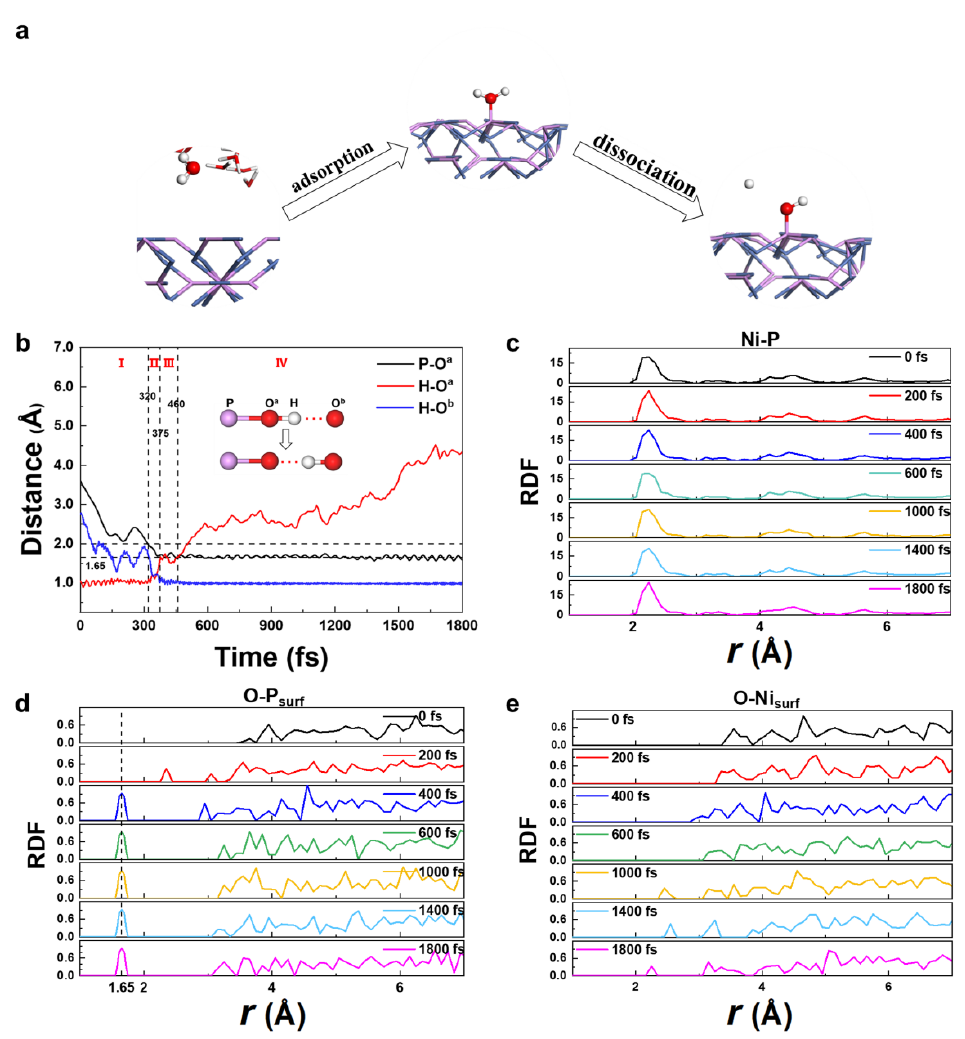
Figure 2. ( a ) Selected snapshots of the AIMD trajectory for Ni 12 P 5 (001)/H 2 O at 300 K. The white, red, purple, and blue spheres represent H, O, P, and Ni, respectively. ( b ) The time evolution of the key bond distances during the AIMD simulation. The black line is the bond distance between the P-O a . The red line is the bond distance between the H-O a . The blue line is the bond distance between the H-O b . H is the dissociated H + , O a is the O atom in *OH; O b is the O atom in another H 2 O. Radial distribution function (RDF) changes over time: ( c ) among Ni and P atom; ( d ) P atoms on the surface and O atom in H 2 O; ( e ) Ni atoms on the surface and the O atom in H 2 O. With the P-O a distance decreasing, one H + of the H 2 O a molecules becomes more and more active and begins to dissociate from the H 2 O a molecule. At 375 fs, the P-O a distance decreases to 1.65 Å, which is close to the P-O σ bond length (1.61 Å) in P 2 O 5 , indicating that the P-O a bond is formed. Meanwhile, one of the H-O a bond lengths increases from 0.98 Å to 1.60 Å, and the dissociated H + forms H 3 O + with another H 2 O molecule. In this process, the hydrogen bond transforms from P-O a -H · · · O b to P-O a · · · H-O b ; the hydrogen bonds length are 2.65